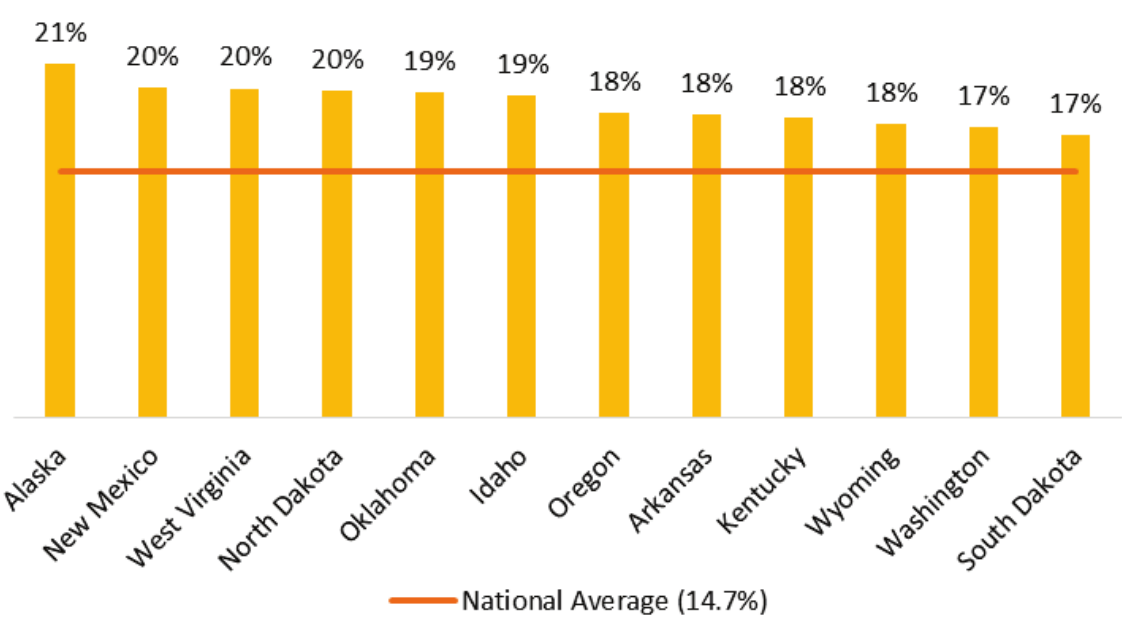
Figure 6: States with highest prevalence of Medicare beneficiaries who are deaf or hard of